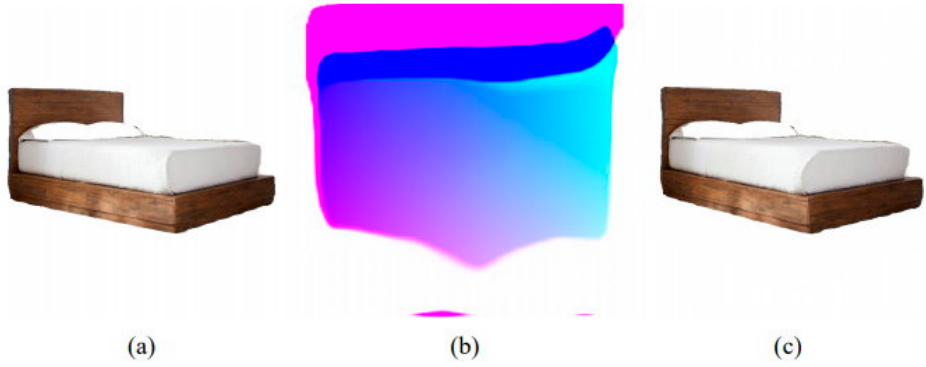
Figure 4. ( a ) The input view of the objects, ( b ) the RGB image of the appearance flow for visualization, and ( c ) the target view of the objects.